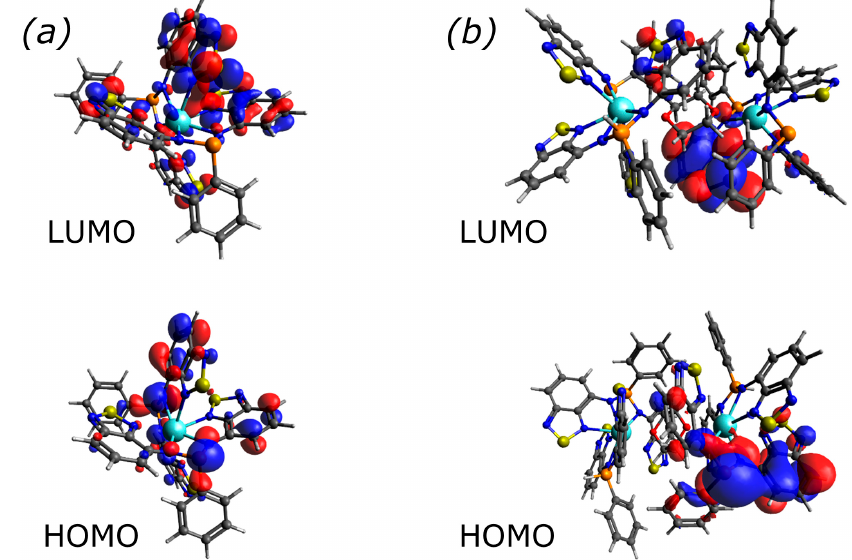
Figure 5. Frontier molecular orbitals for the complexes ( a ) [YL 2 ] – and ( b ) [{YL(HL)} 2 (dioxane)] at TD-PBE0/def2-TZVPD level (isovalue = 0.03).